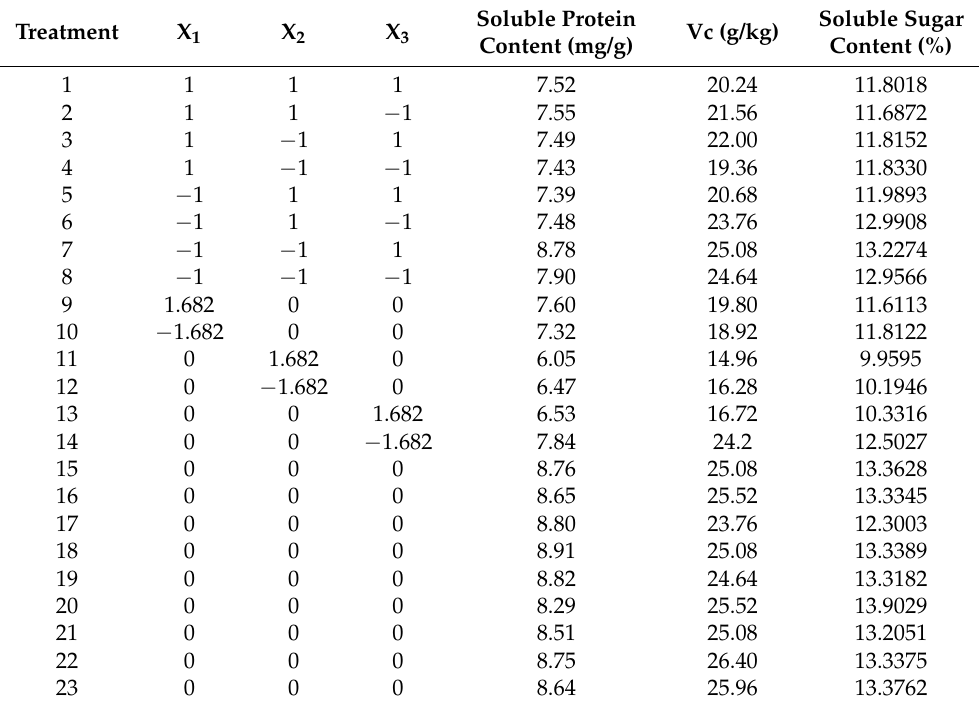
Table 4. The contents of soluble protein, Vc, and soluble sugar under the different treatments.